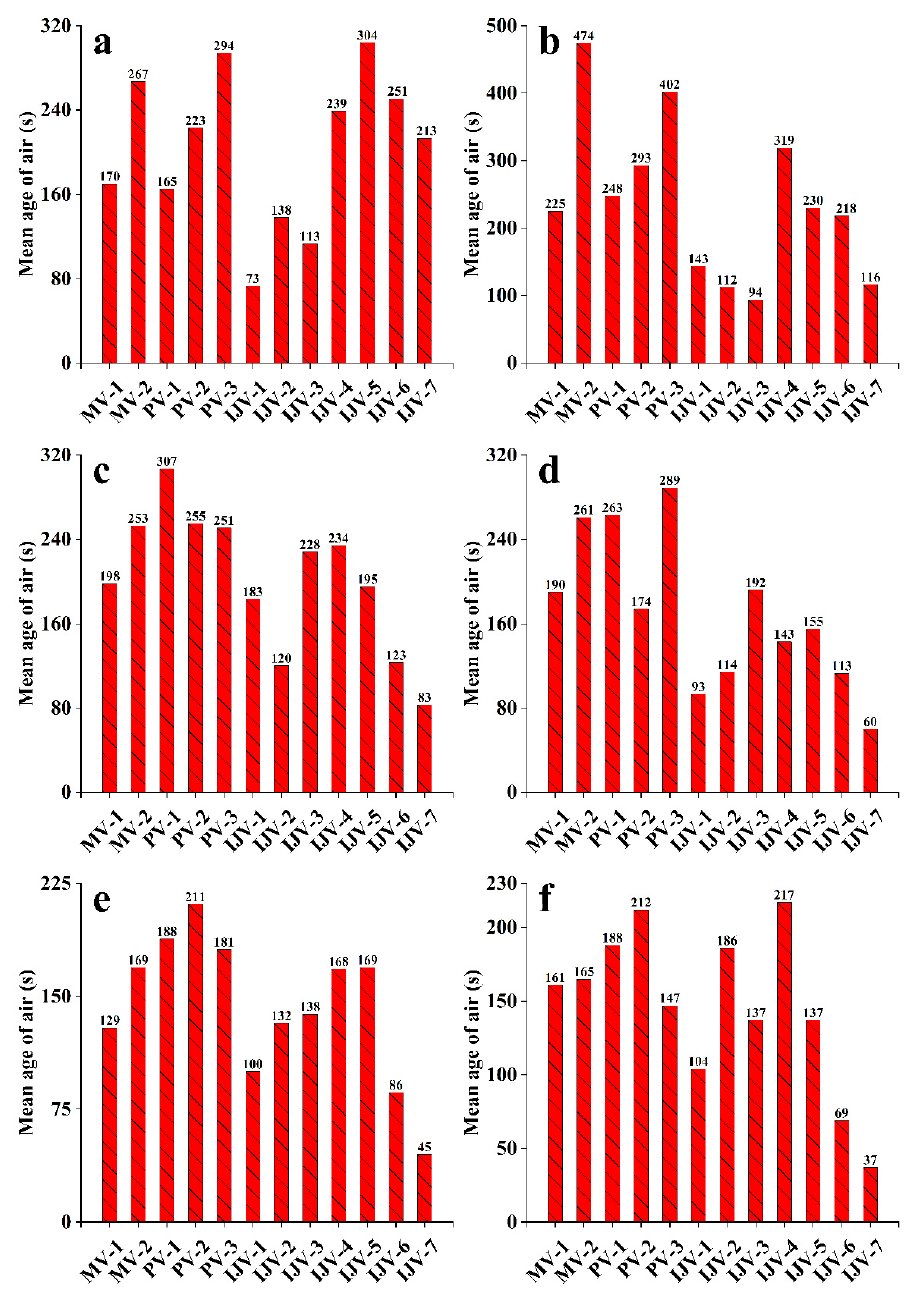
Figure 10. Air age in different scenarios ( a – f ): ACH = 5–30. When the jet ventilation air supply outlet is higher than the monitoring surface (IJV- 5), the MAA on the monitoring surface is long. The MAA in the area far away from the air